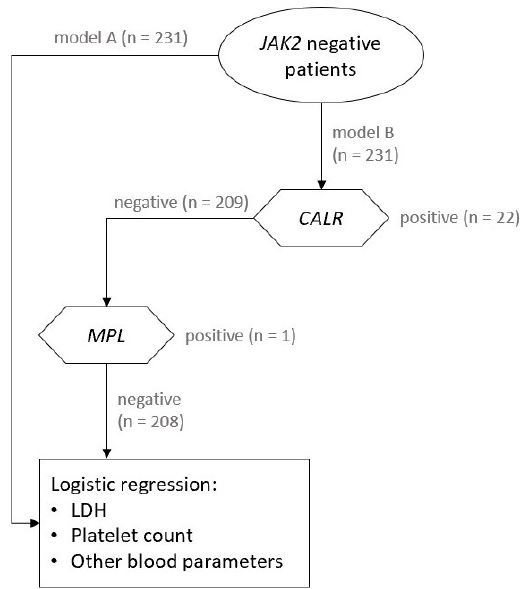
Figure 1. The schematic presentation of our statistical analysis with models A and B.